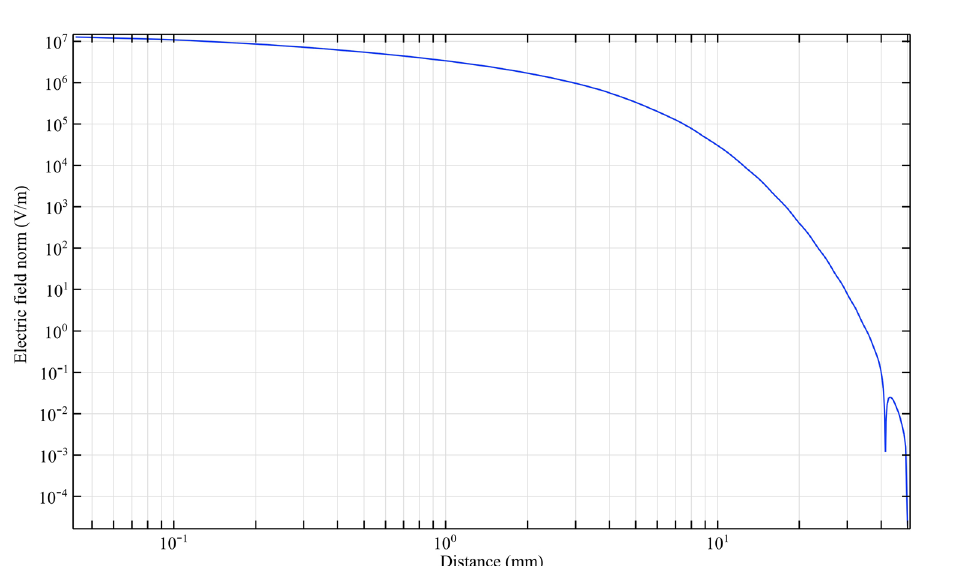
Figure 13. Simulation of electric field from tip electrode to end of plasma jet nozzle based on nozzle Fig.